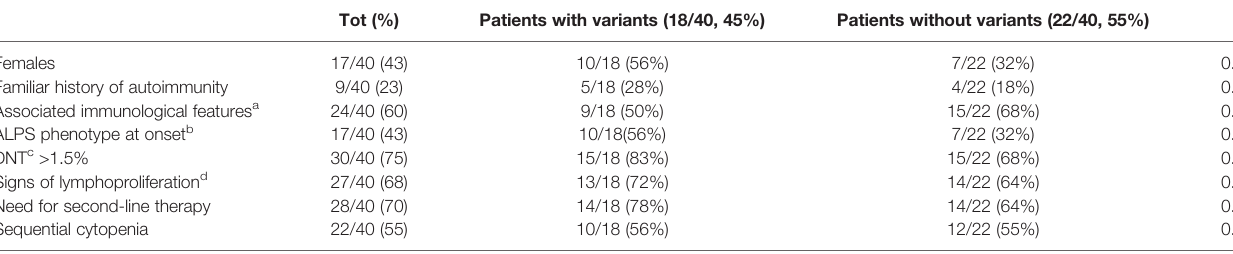
TABLE 5 | Clinical and immunological differences according to variants.